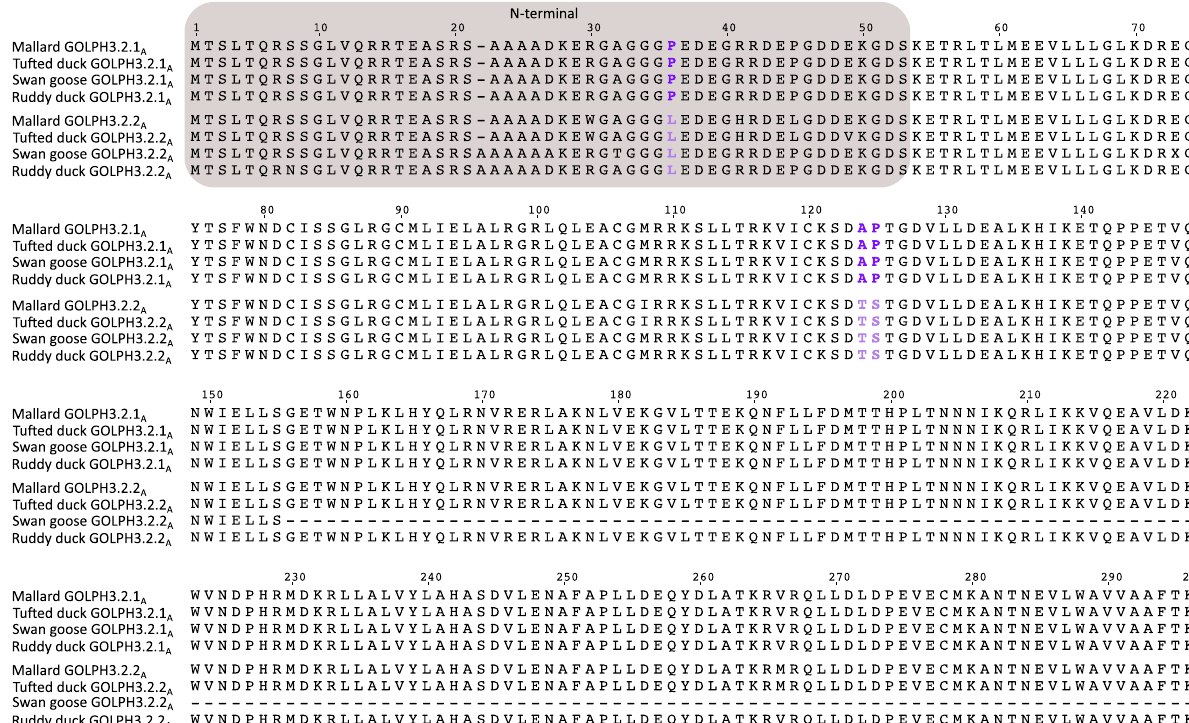
Figure 4. Alignment of Golgi phosphoprotein 3 (GOLPH3) amino acid sequences from mallard ( Anas platyrhynchos ), Tufted duck ( Aythya fuligula) , swan goose ( Anser cygnoides ) and ruddy duck ( Oxyura jamaicensis ). Amino acids positions that differentiate between paralogs are in purple and light purple. The N-terminal region of the protein is